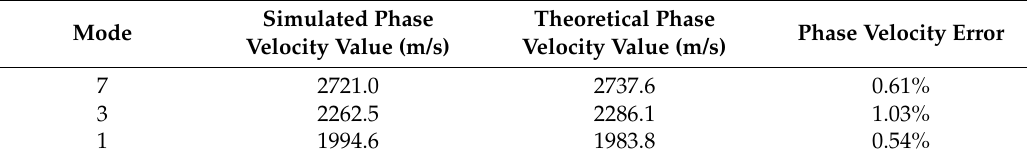
Table 6. Phase velocities of reflected echo modes.